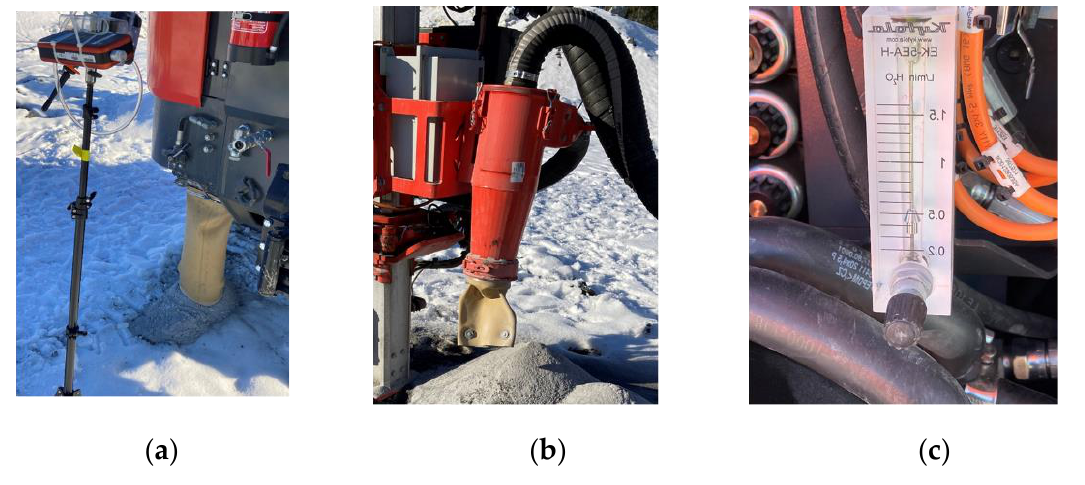
Figure 4. ( a ) Drill rig back separator with soc. ( b ) Front separator with soc. ( c ) Water supply adjustment of drill rig (ca. 0.4 dm 3 /min). Reproduced with permission from Tuomi et al., Finnish Institute of Occupational Health, 2022 [34].